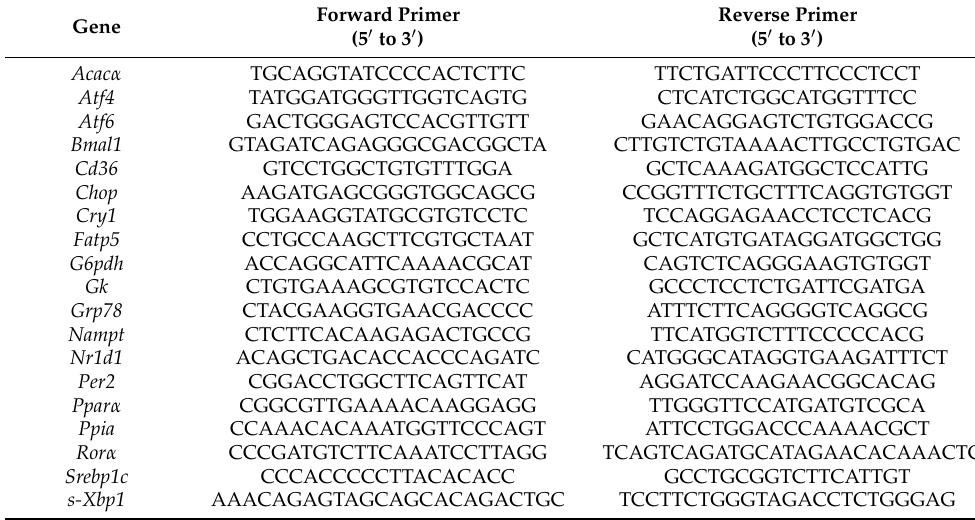
Table 1. Nucleotide sequences of primers used for real-time quantitative PCR. Forward Primer Gene (5 (cid:48) to 3 (cid:48)